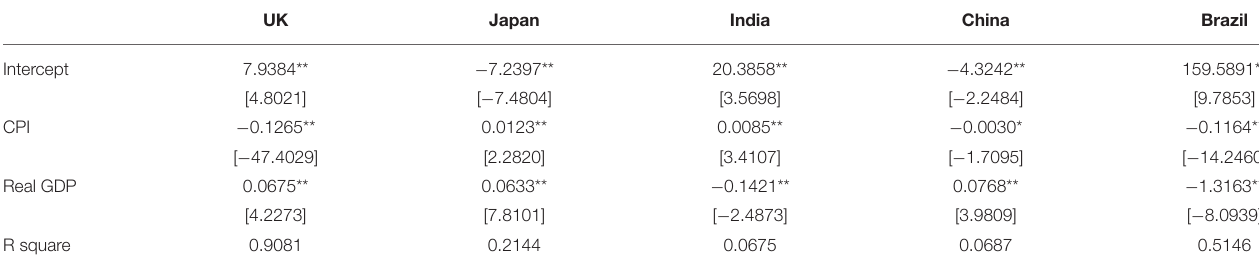
TABLE 1 | Regression